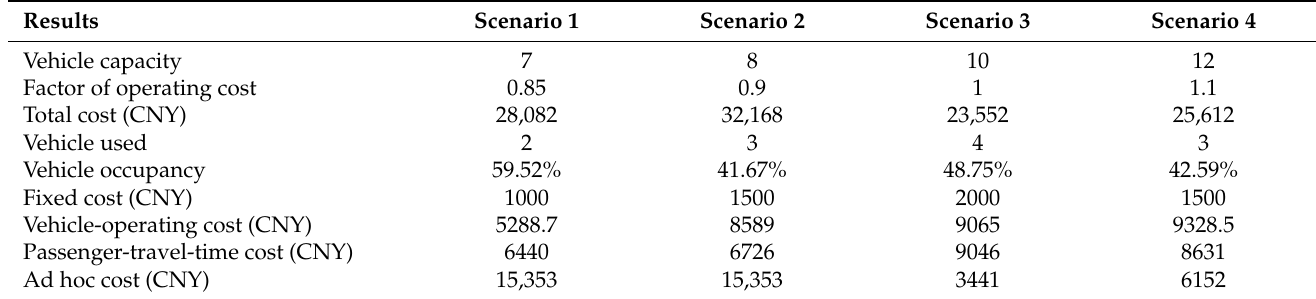
Table 5. Results under different vehicle capacities and operating costs.